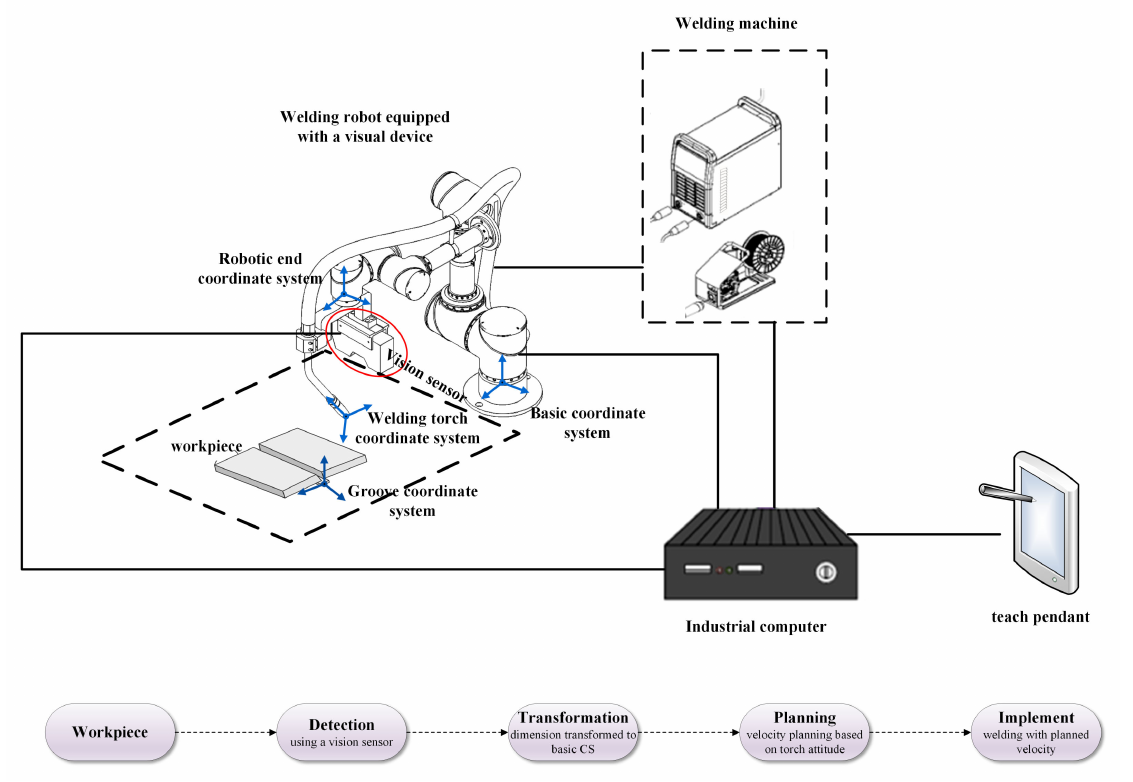
Figure 4. Diagram of the robotic and visual welding system. The co-ordinate systems are represented in